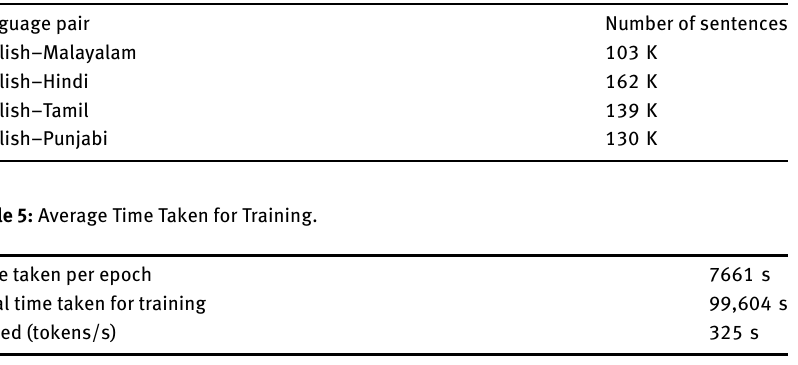
Table 6: Classification of Sentences in Each Language Pair Based on the Number of Words Present in the